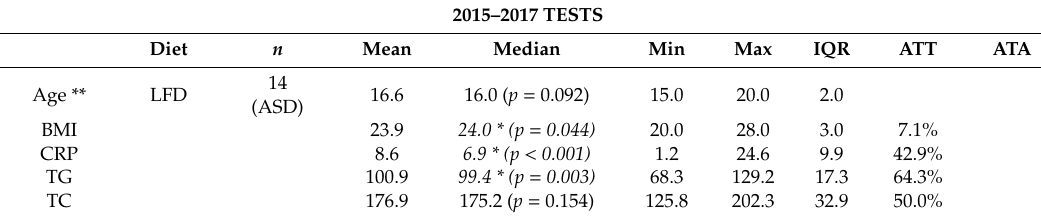
Table 1. Studied variables and their comparison for two assessment periods (IQR—interquartile range; ATT—above threshold teenagers; ATA—above threshold